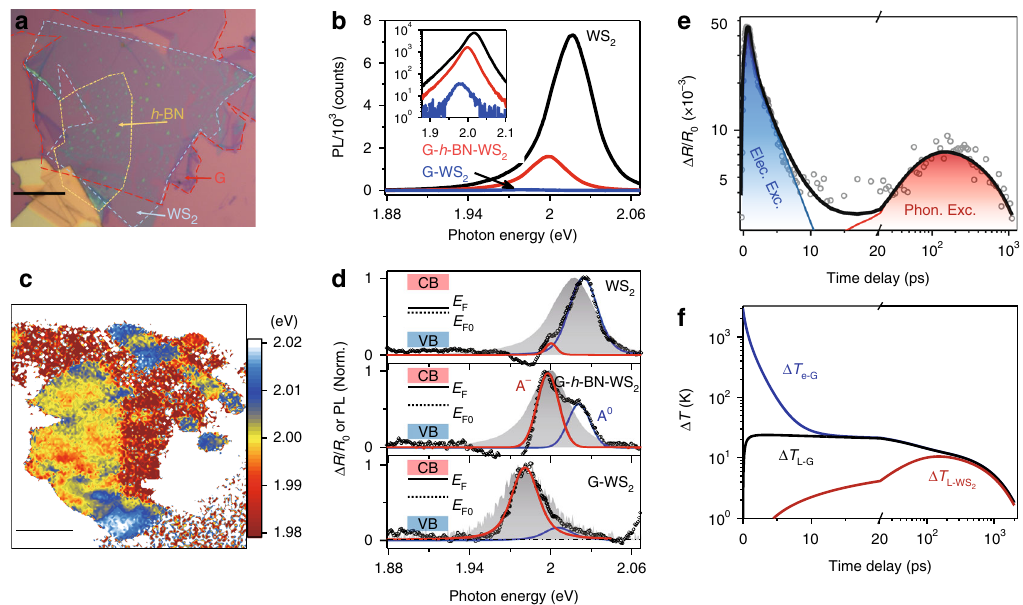
Fig. 2 APR process induced by the rising Fermi energy. a Optical image of the graphene-based heterostructure (Sample 1). Scale bar, 10 μ m. b PL intensity for different sample regions of a . Inset: The same data with a log y -axis. c PL peak energy image of the heterostructure. Scale bar, 10 μ m. d Comparison of the normalized PL (grey area) and TA (black dots) spectra. The TA spectra are pumped by an up-bandgap photon energy (2.1 eV) and fi tted based on a neutral exciton (A 0 , blue line) and a charged trion (A − , red line), with an energy shift (trion binding energy) of ~25meV. (Inset) Illustration of the Fermi level position in different sample regions. e Comparison of the measured (dots) and simulated (line) photocarrier dynamics. The blue and red areas represent the electronic and phononic excitation components, respectively. f Thermal transport model-predicted carrier cooling process in graphene ( T e − G ), and lattice temperature relaxation in both graphene ( T L − G ) and WS 2 ( T ). For e , f , the pump energy is 0.48eV, and the pump fl uence is ~34 μ J cm − 2 L (cid:2) WS 2